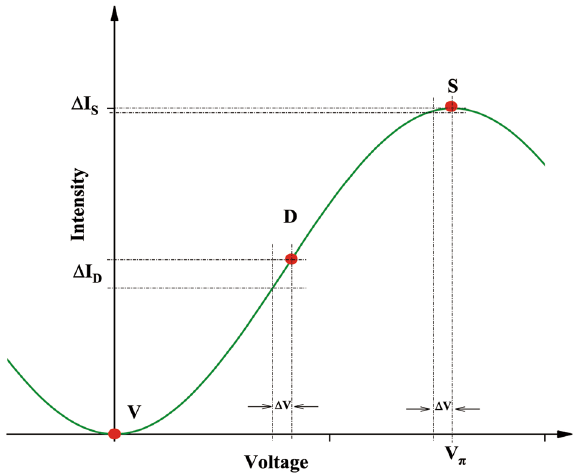
Fig. 1 The voltage response curve of a commercial LiNbO 3 -based MZI with 50:50 splitting ratio. With the same voltage disturbance Δ V , the intensity difference Δ I on the slope point D is signi fi cantly larger than it on the stable point S . The V π denotes the half-wave voltage.